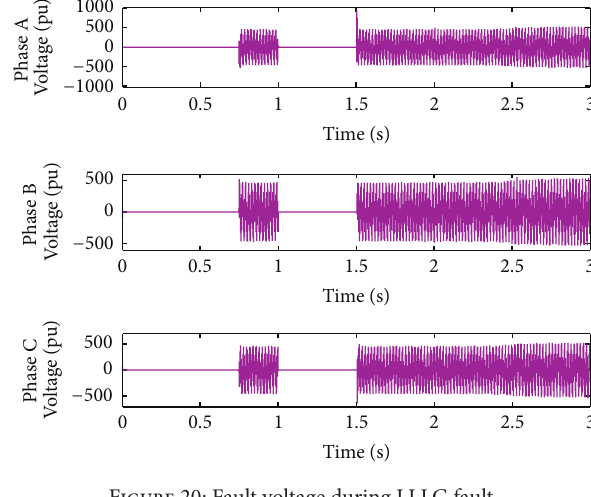
Figure 20: Fault voltage during LLLG fault.